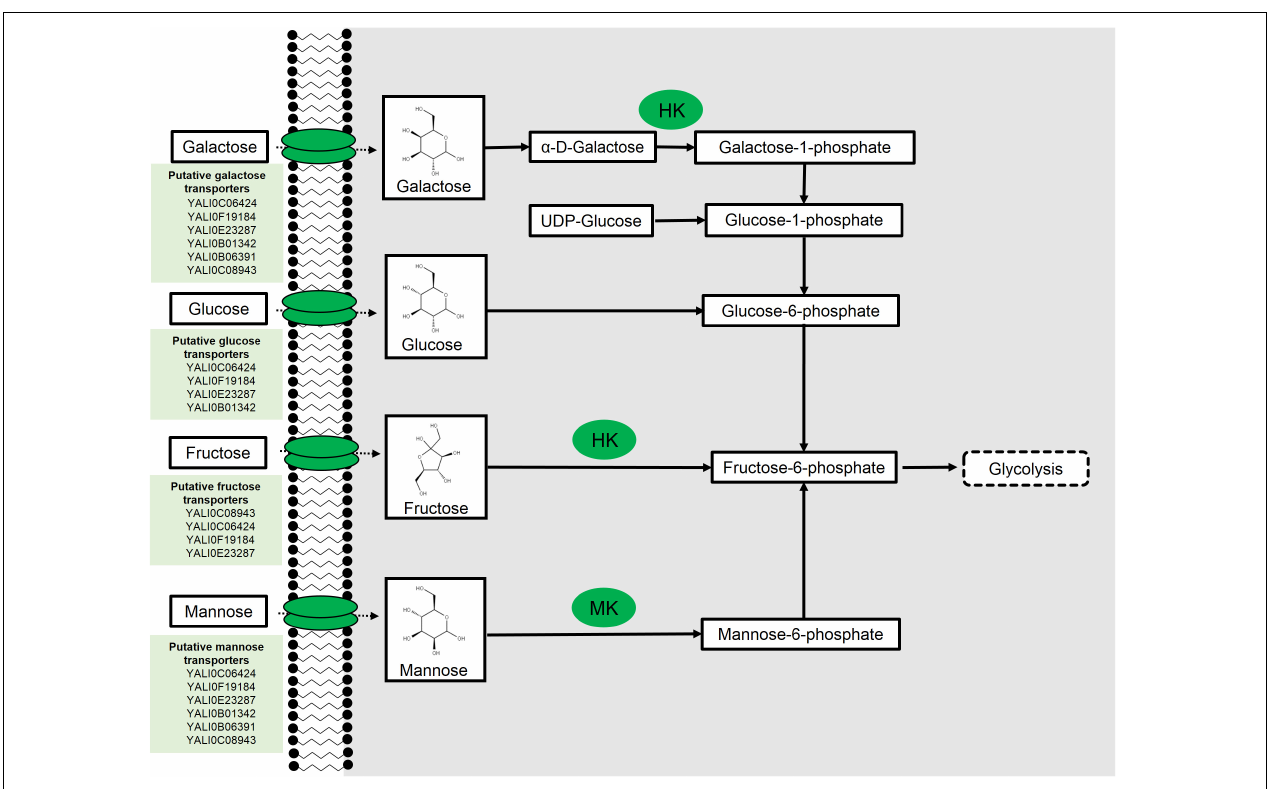
FIGURE 1 | Hexose metabolism in Yarrowia lipolytica . Hexokinase (HK) and mannokinase (MK). Putative transporter results from Lazar et al.